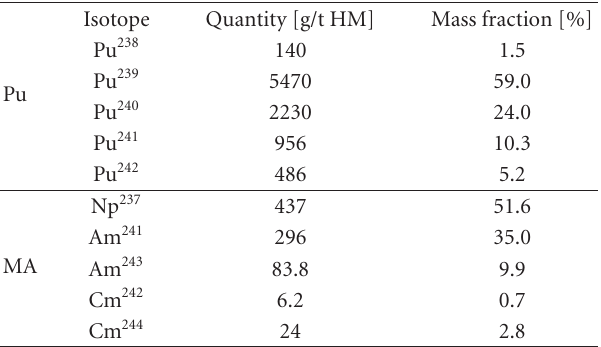
Table 1: Spent LWR HM composition (burnup 33 GWD/tHM; initial enrichment 3.2%U 235 ; 5 years cooling).